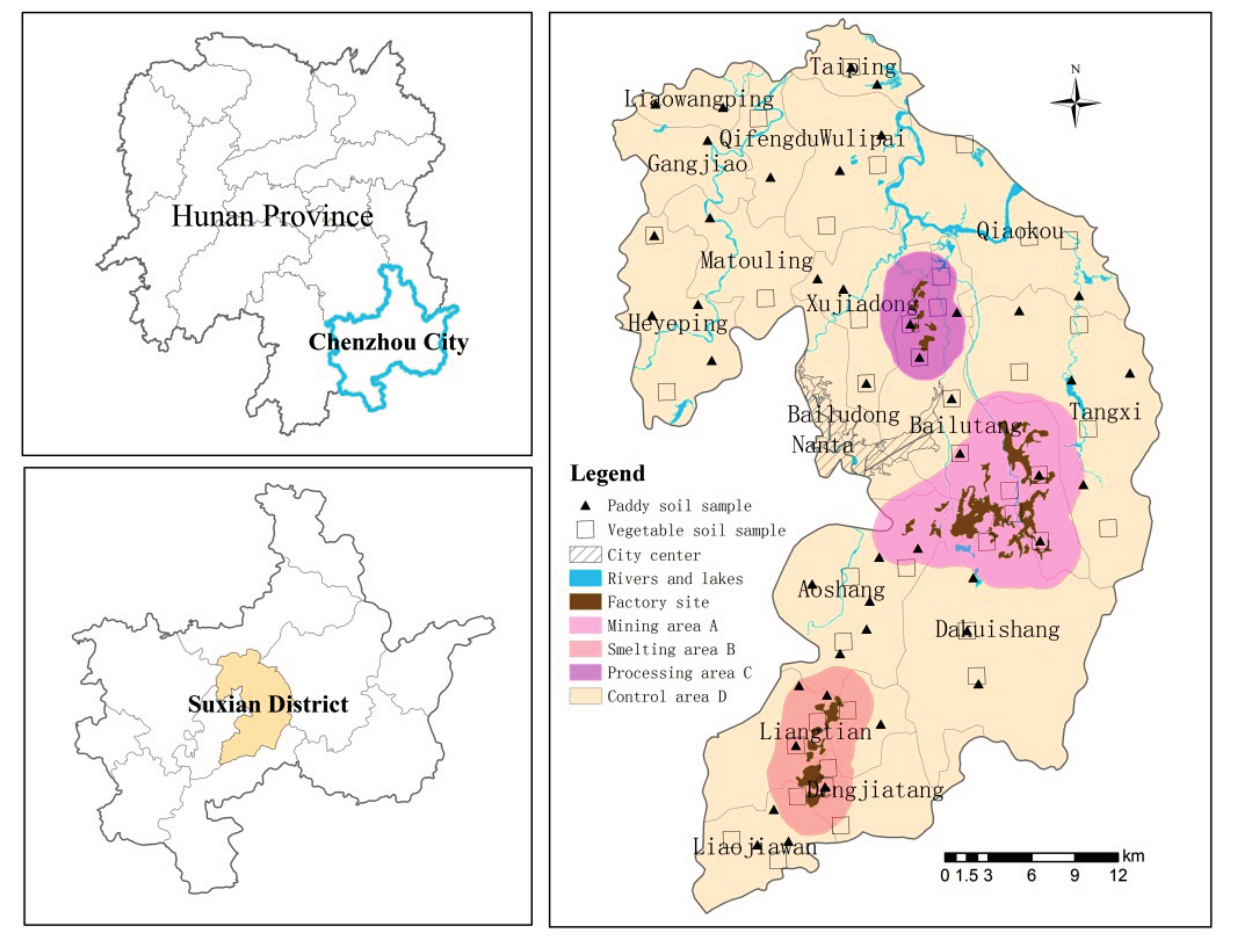
Figure 1. Illustration of sampling sites in Suxian County in Hunan Province, South